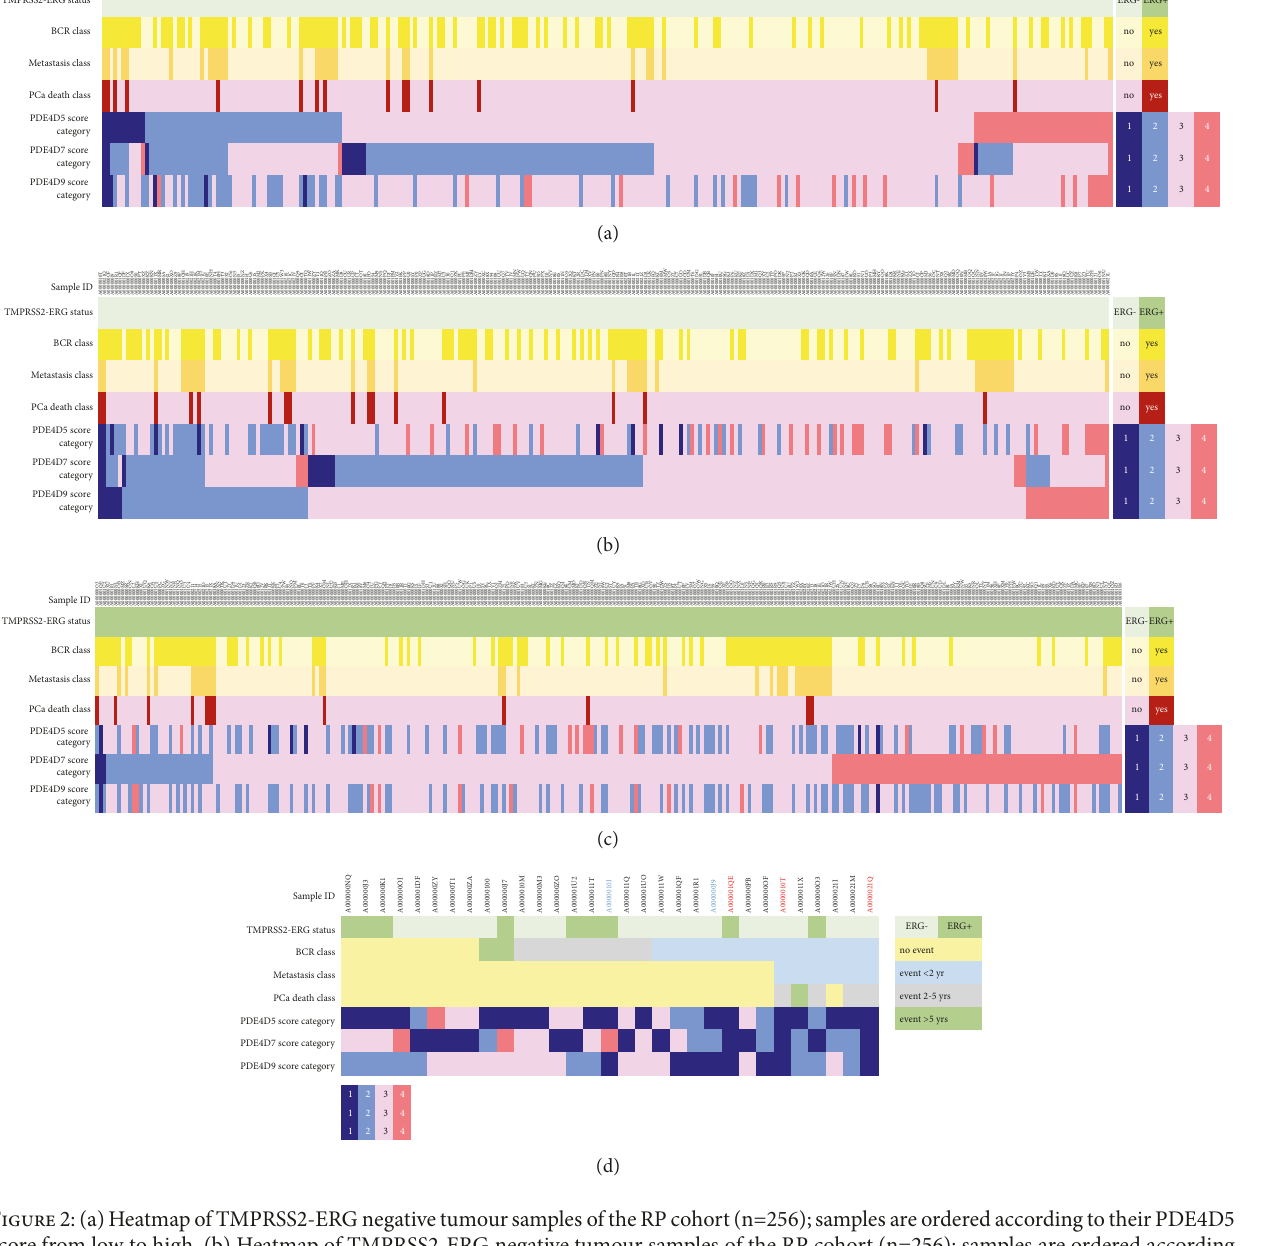
Figure 2: (a)Heatmapof TMPRSS2-ERG negativetumoursamples of theRP cohort(n=256);samples are ordered accordingtotheirPDE4D5 score from low to high. (b) Heatmap of TMPRSS2-ERG negative tumour samples of the RP cohort (n=256); samples are ordered according to their PDE4D9 score from low to high. (c) Heatmap of TMPRSS2-ERG positive tumour samples of the RP cohort (n=280); samples are ordered according to their PDE4D7 score from low to high. The legends of the graphs and color coding are defined as ‘Sample ID’: IDs of the 256 TMPRSS2-ERG negative tumour samples of the RP cohort. ‘TMPRSS2-ERG status’: presence (dark green) or absence (light green) of the gene fusion event in a given sample. ‘BCR class’: every patient is coded for the presence (dark yellow) or absence (light yellow) of a BCR (biochemical recurrence) event during the > 120 months median follow-up. ‘Metastasis class’: every patient is coded for the presence (dark orange) or absence (light orange) of a metastases event during the > 120 months median follow-up). ‘PCa death class’: every patient is coded for the presence (dark red) or absence (light red) of a prostate cancer specific death event during the > 120 months median follow-up. PDE4D5, PDE4D7, and PDE4D9 score categories were defined as PDE4D5/7/9 (1-2): PDE4D5/7/9 scores (1 to < 2; dark blue); PDE4D5/7/9 (2-3): PDE4D5/7/9 scores (2 to < 3; light blue); PDE4D5/7/9 (3-4): PDE4D5/7/9 scores (3 to < 4; light pink); PDE4D5/7/9 (4-5): PDE4D5/7/9 scores (4 to < =5; dark pink). (d) RP cohort patient samples (n=31) with the lowest PDE4D5, PDE4D7, and PDE4D9 scores. The legends of the graph and color coding are defined as above with the change of a color coding for BCR, Metastasis, and PCa Death class according to a time interval to the event; light yellow: no event during > 120 months median follow-up; light blue: < 2 years to the event during > 120 months median follow-up; light grey: 2-5 years to the event during > 120 months median follow-up; light green: > 5 years to the event during > 120 months median